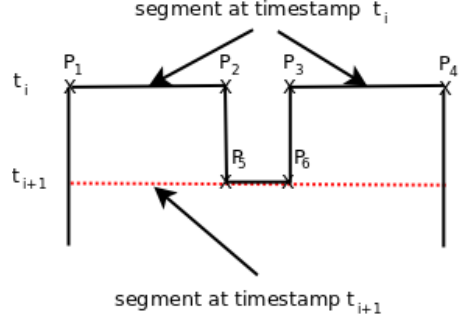
Figure 4. Sweep algorithm to scan orthogonal